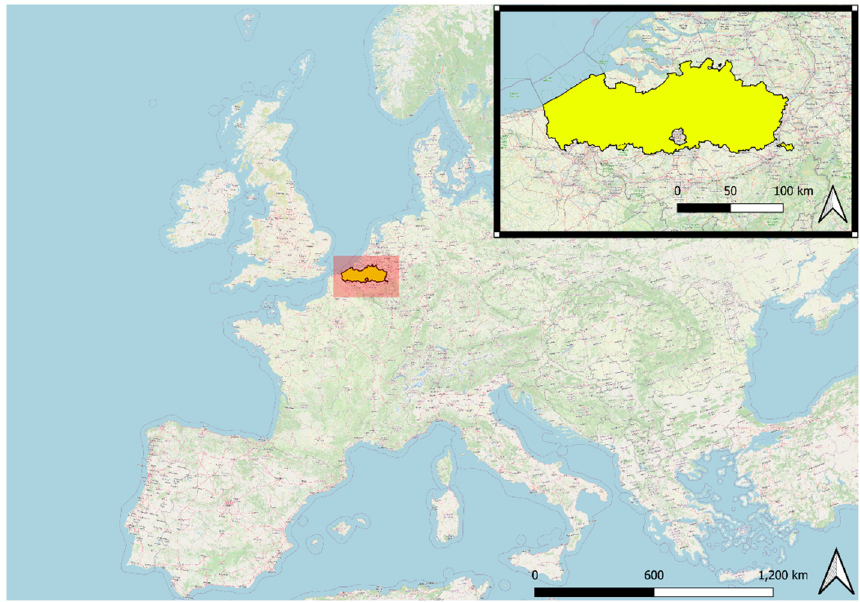
Figure 1. The location of the study area in Europe.